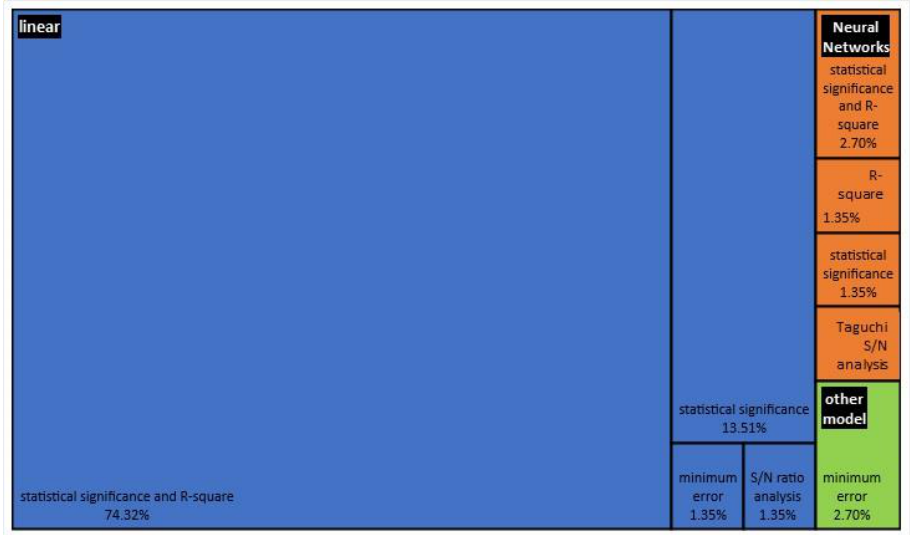
Figure 11. RSM modeling stage.